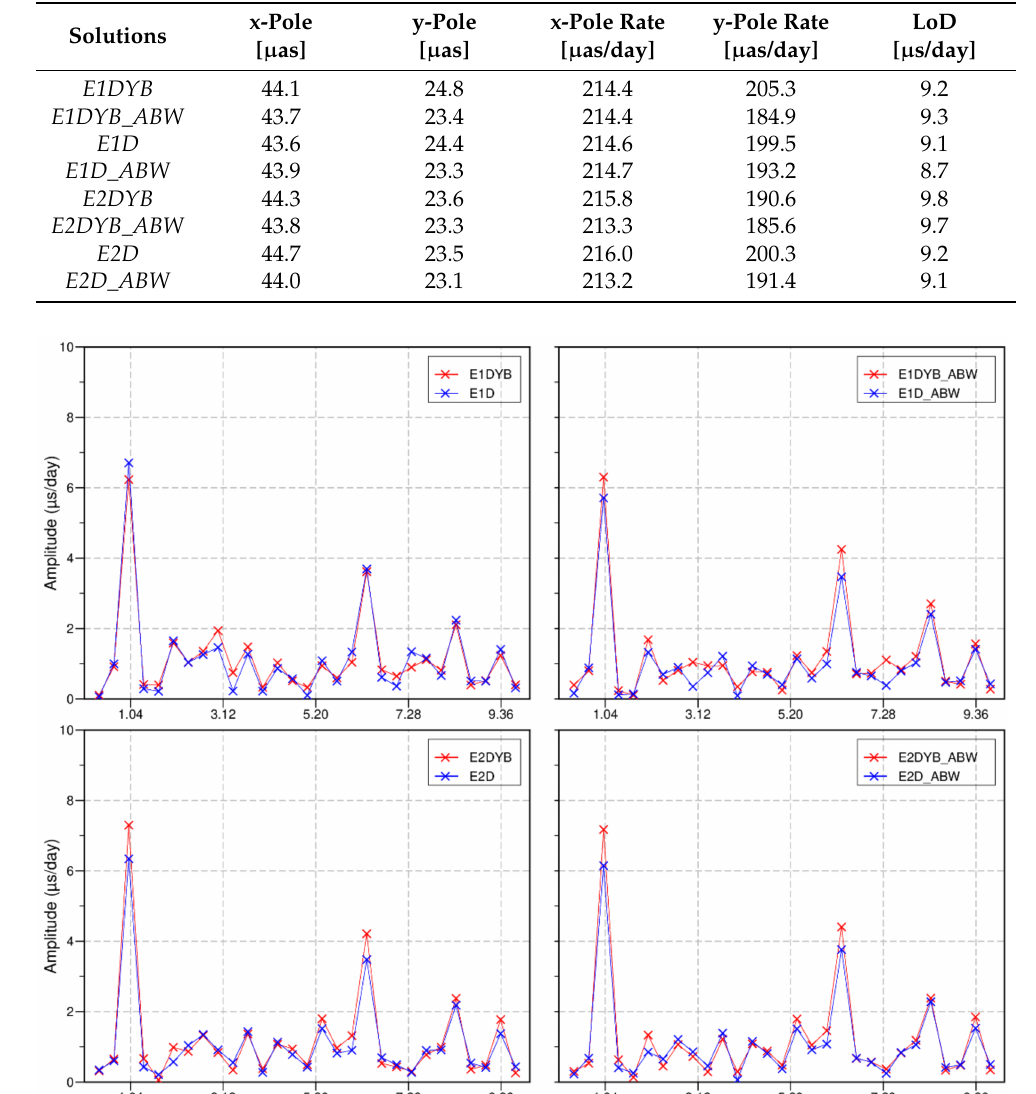
Table 4. WSTD values of the ERP differences between GPS precise orbit determination solutions and the IERS EOP 14C04 product. Note that there is no difference between using no a priori SRP model and using the box-wing model; the solutions using the box-wing model are thus not presented.